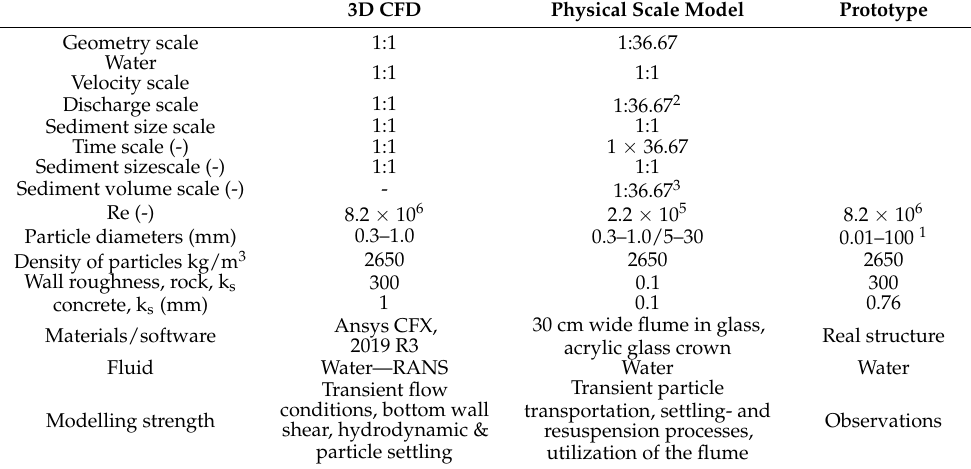
Table 1. Modelling